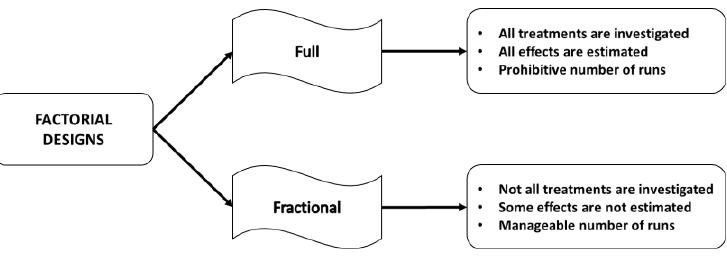
Figure 2. Advantages and disadvantages of full and fractional designs.